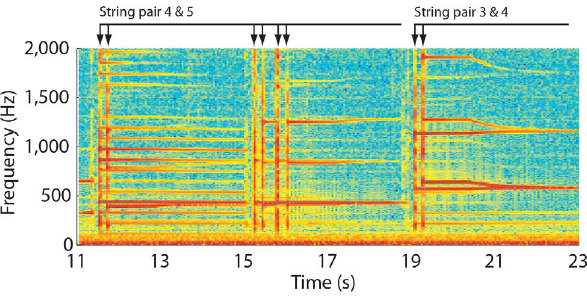
Figure 1. Spectrogram of a guitar being tuned in real time by CI1. Frequency is on the y-axis, and time on the x-axis. Arrows at the top of the plot indicate when the strings were plucked, and the bars delineate each pair of strings.